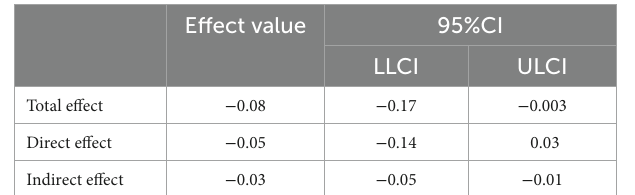
TABLE 2 Mediating effect